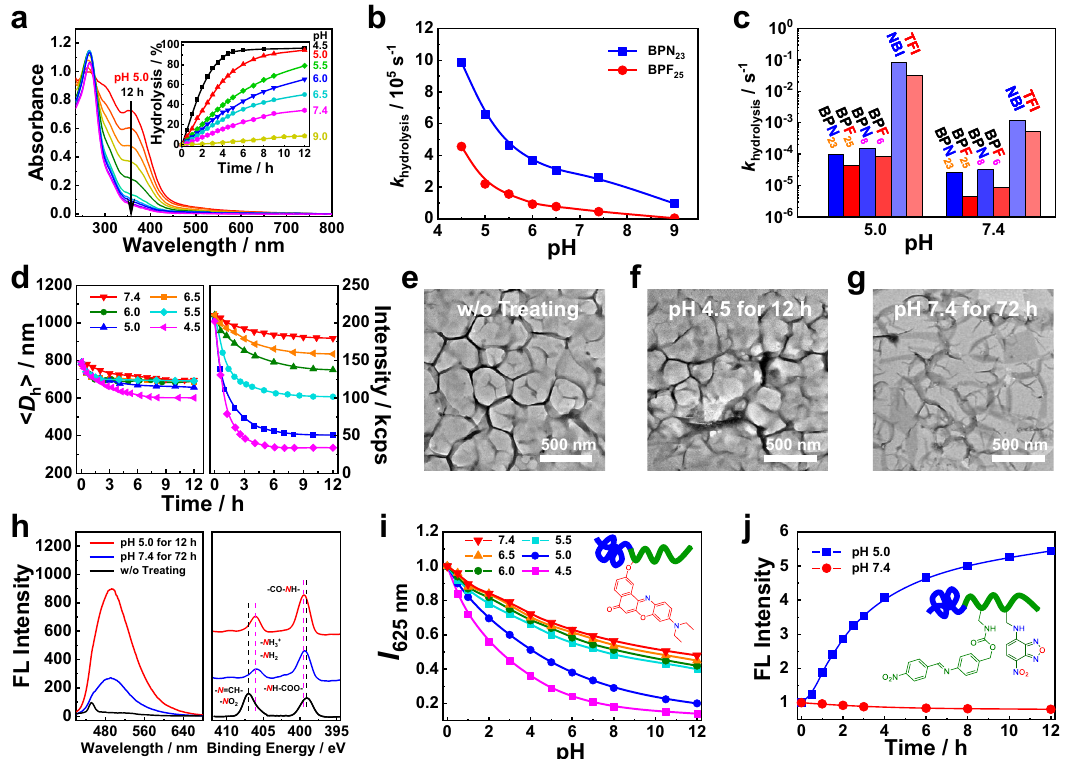
Fig. 2 pH-regulated imine hydrolysis, self-immolative cleavage, bilayer crosslinking, and membrane permeabilization. a Time-dependent evolution of UV-Vis absorbance spectra and hydrolysis kinetics of imine linkages (inset) recorded for aqueous dispersions of BPN 23 polymersomes (0.2 g/L) at varying pH. b pH-dependent variation and c summary of hydrolysis rate constants, k hydrolysis , of imine linkages determined for aqueous dispersions of BPN and BPF polymersomes (~400 μ M imine linkages); k hydrolysis values of small molecule NBI and TFI (400 μ M in DMSO/water, 3/7 v/v) are included for comparison. d Time-dependent evolution of scattered light intensities (left) and intensity-average hydrodynamic diameters, < D h > (right), recorded for BPN 23 polymersome dispersion (0.2 g/L) at varying pH. e – g TEM images (scale bars: 500 nm) recorded for BPN 23 polymersomes (0.2 g/L) before ( e ) and after incubating at pH 5.0 for 12 h ( f ) and pH 7.4 for 72 h ( g ). h , left, Fluorescence emission spectra ( λ ex = 390 nm) recorded for BPN 23 polymersome dispersion upon incubating at pH 5.0 for 12 h and pH 7.4 for 72 h, followed by reacting with fl uorescamine (FA) for 15 min in PBS buffer (pH 7.4). h , right, XPS N1s spectra of lyophilized BPN 23 polymersome dispersions (0.2 g/L) after hydrolysis at pH 5.0 for 12 h and pH 7.4 for 72 h. i , j Time-dependent evolution of emission intensities recorded for i BPN 24 - NR ( λ ex = 550nm, λ em = 625 nm) and j BPN 21 - NBD ( λ ex = 480 nm, λ em = 550 nm) polymersome dispersions (0.2 g/L) in the pH range of 4.5 –